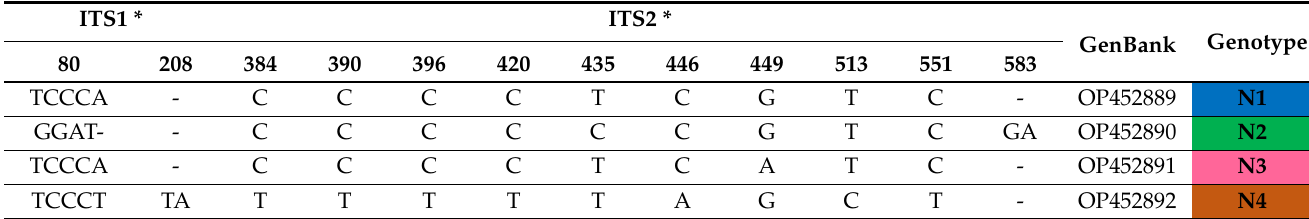
* The base position corresponds to the genotype N4 sequence as reference. -, deletion. Table 3. Haplotypes detected with the plastid markers ( pet B- pet D IGS + petD intron and trn L (UAA) intron + trn L (UAA) - trn F (GAA) IGS) in the Limonium populations and type specimens. See Figure 4 for the distribution map.